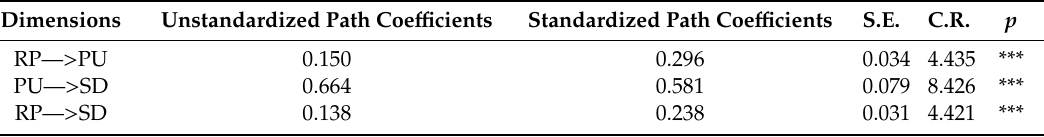
Table 6. The path coe ffi cient values of the